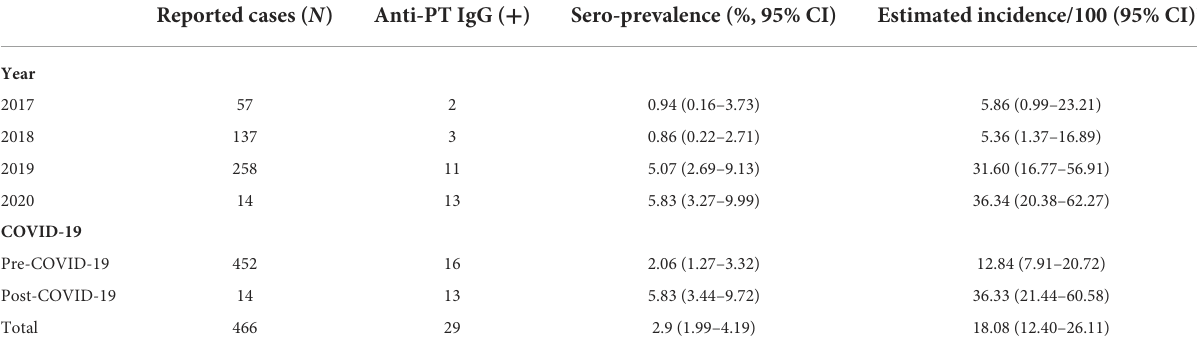
CI,confidenceinterval. * Therateofpertussisinfectioncanbeestimatedusingtheformula:365.25/58.6 × Sero-prevalence ≥ 100IU/ml,butitrepresentstherate1yearbefore,thenumbers for2021areusedtoestimate theincidencefor2020, andsoforth. Data for2022wereunknownandwewereunabletoestimate theincidencefor2021, soweincludedonly2020 valuesin